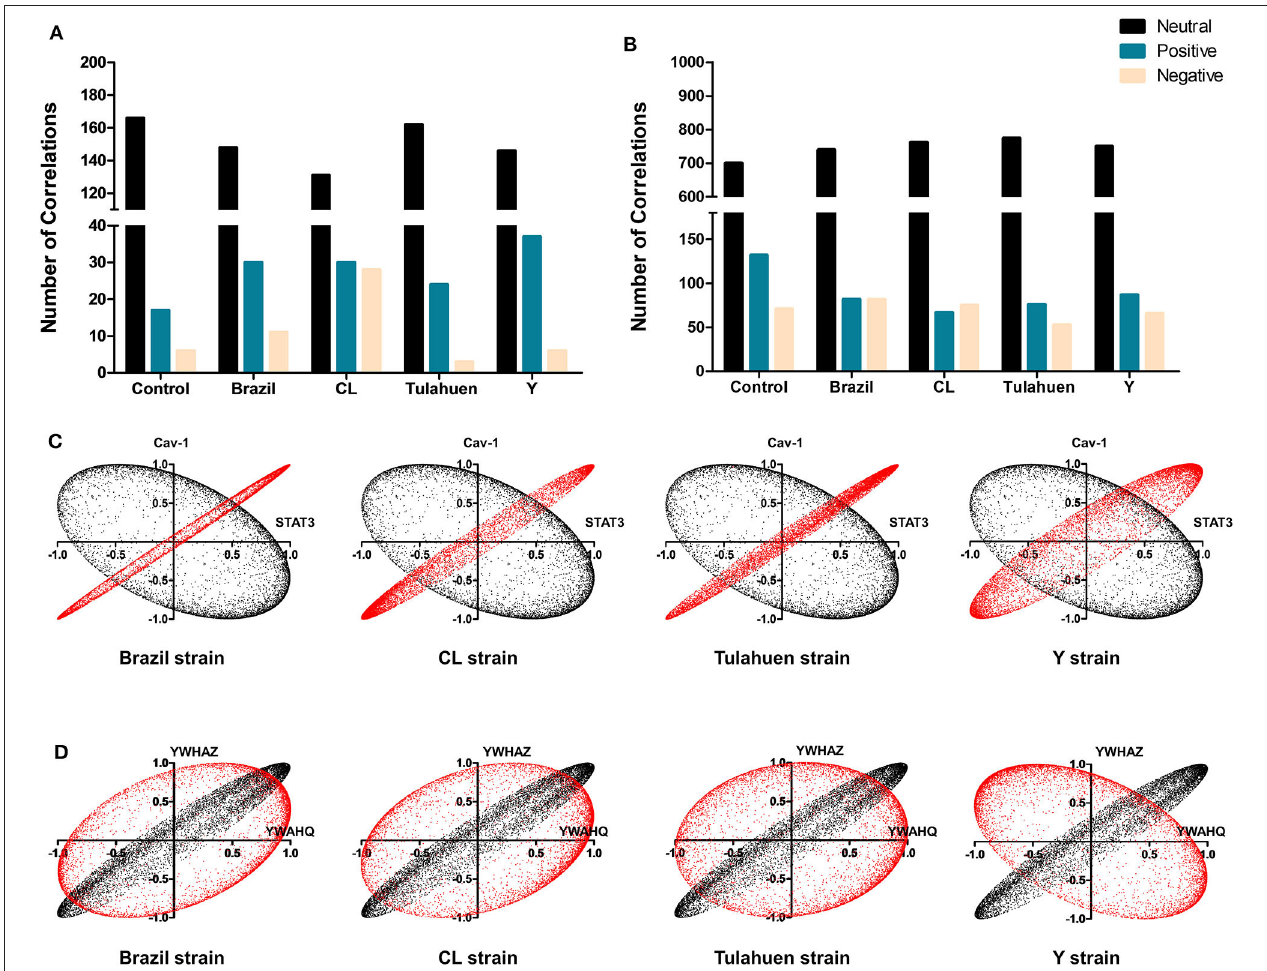
FIGURE 5 | Differential effects of infection on global gene correlation. Plots of correlation coefficients between the expression levels of the indicated genes with each other genes differentially expressed in each experimental condition. The number of neutral (black bars), positive (blue bars), and negative correlations (yellow bars) was quantified among genes belonging to the JAK/STAT (A) and Cell Cycle (B) pathways . T. cruzi infection increased the number of positive correlations of the JAK/STAT pathway, whereas an opposite effect was observed for Cell Cycle genes. In (C,D) are depicted representative correlation profiles of each pathway: cav-1 and stat3 of the JAK/STAT pathway (C) and YWHAZ and YWHAQ of the Cell Cycle Pathway (D) . Profiles of the uninfected controls are represented by the black dots and T. cruzi -infected by red